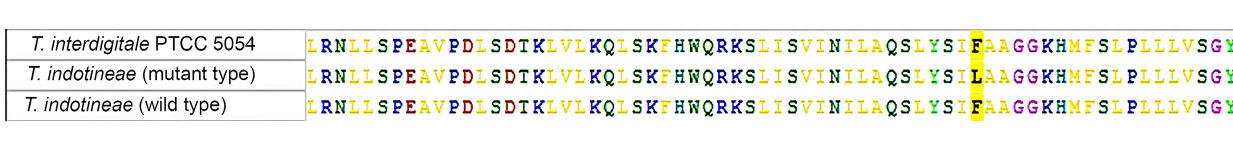
Frontiers in Cellular and Infection Microbiology |